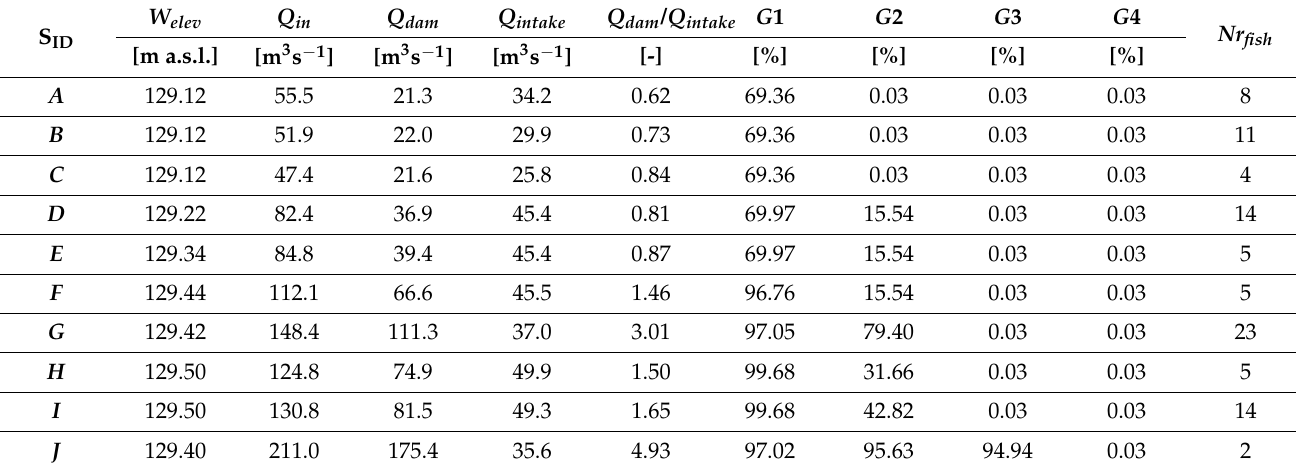
Table 1. The scenarios for CFD modeling ( A – J ) with water surface elevation ( W elev (m above sea level (m a.s.l.)), inlet discharge ( Q in (m 3 s − 1 )), discharge through the dam ( Q dam [m 3 s − 1 ]) and through the intake ( Q intake (m 3 s − 1 )). The dimensionless ratio between the two outlets ( Q dam / Q intake ) is also presented. The gate openings ( G 1– G 4) indicate the percentage (%) of the actual opening of the gates. Note that below 16%, the gate was considered closed ( TronderEnergi , personal communication). The number of fish ( Nr fish ) sorted into each scenario is also